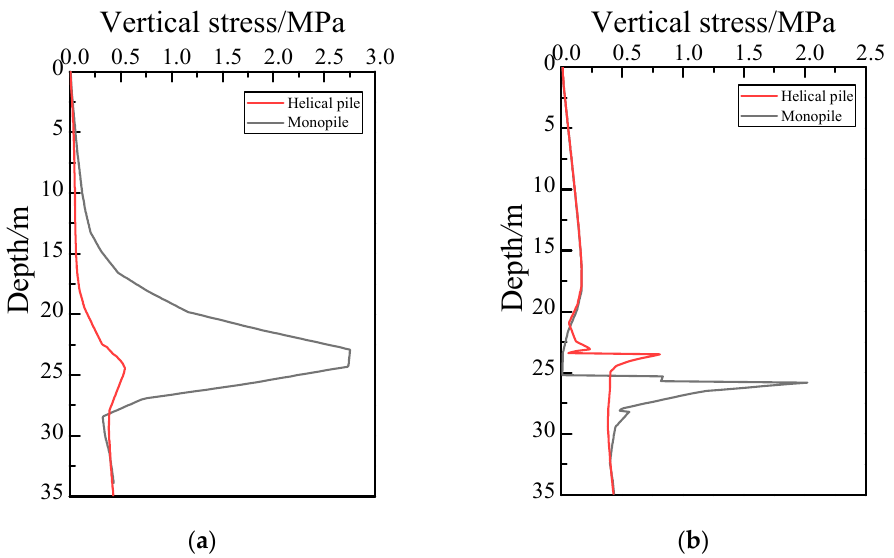
Figure 8. Soil stress inside and outside the pile varies with depth. ( a ) Soil stress in pile; ( b ) Soil stress outside pile.